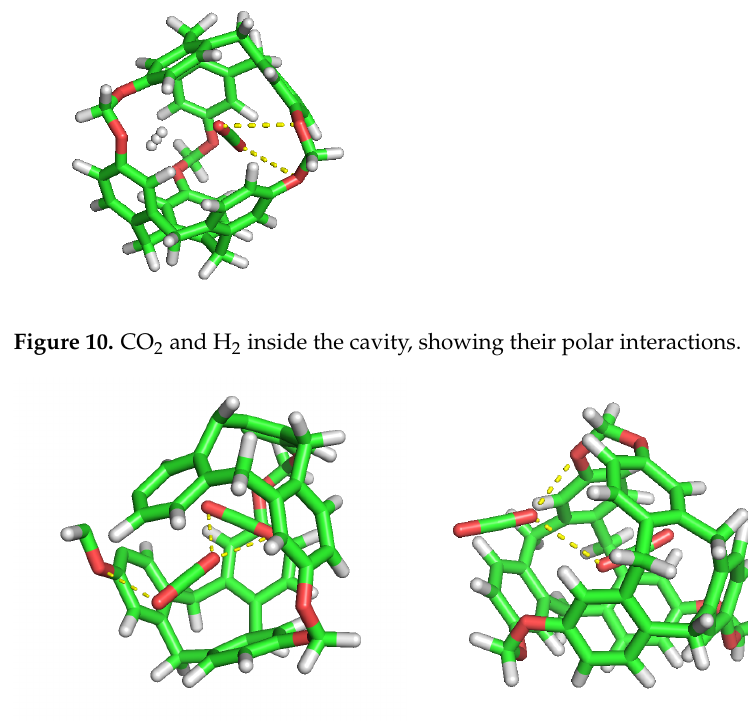
Figure 11. Double CO 2 occupancy within a cavity showing their